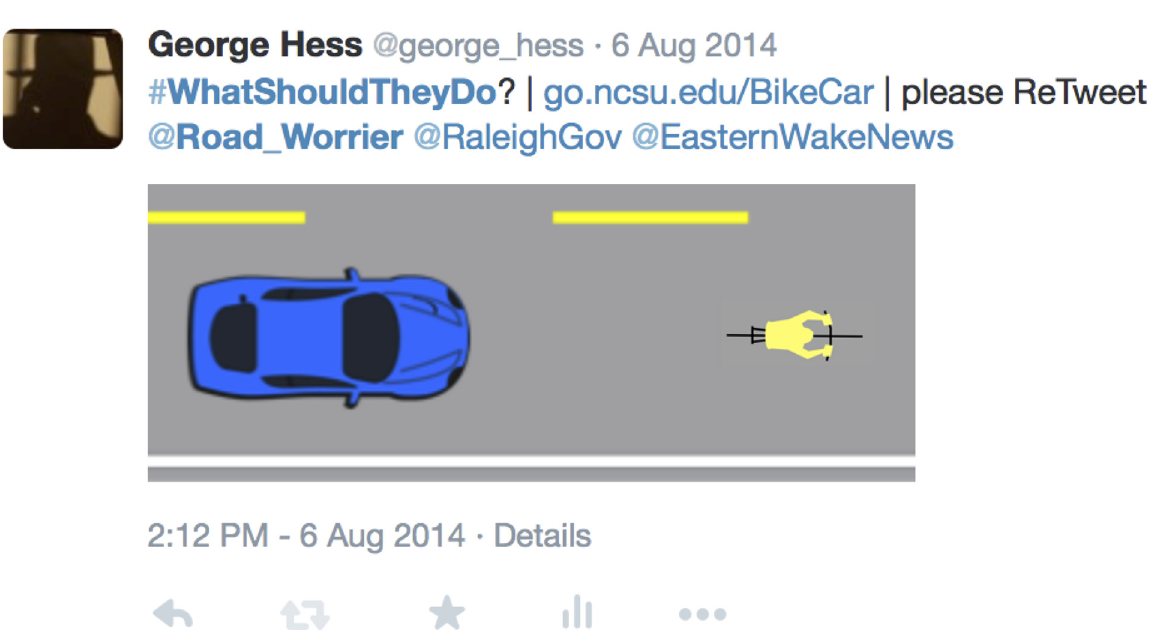
Fig 3. Example tweet. Each tweet included a request that the viewer complete our survey and retweet it and was directed at other Twitter users (the @handles) and Twitter users interested in specific issues (keywords preceded by